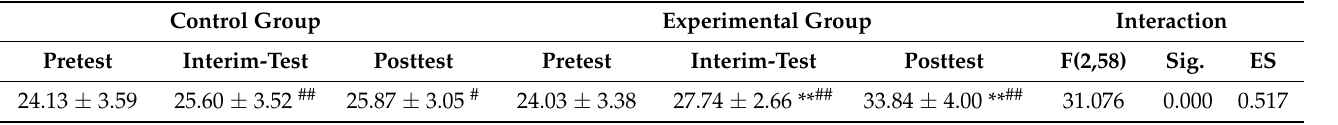
Table 7. Between-group comparison of overall social interaction scores across three intervals. Control Group Experimental Group Interaction Pretest Interim-Test Posttest Pretest Interim-Test Posttest